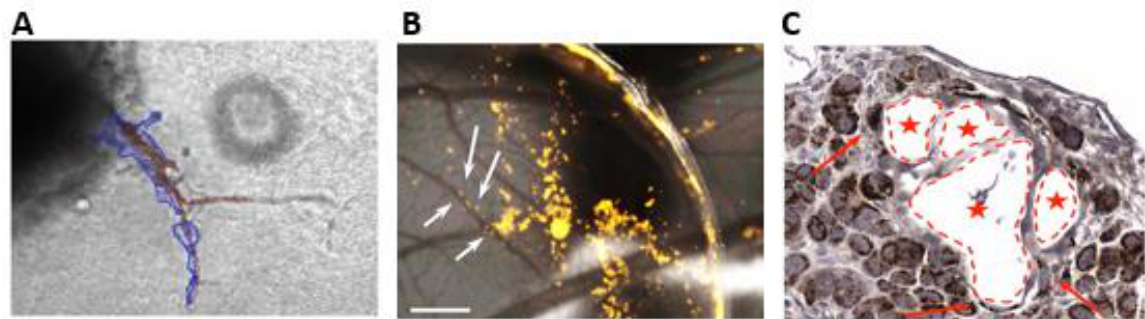
Figure 2. Experimental approaches for studying EVMM. ( A ) 3D matrigel-embedded spheroids of endothelial (highlighted in brown) and melanoma (highlighted in blue) cells; ( B ) Chick embryo chorioallantoic membrane (CAM). White arrows highlight melanoma cells (yellow) in close contact with the abluminal side of blood vessels. Scale bar 2 mm; ( C ) Histological image of metastatic melanoma cells in CAM section. Melanoma cells are stained with anti-human mitochondria (brown dots, DAB), and the lumen of the vessels are highlighted with red stars.